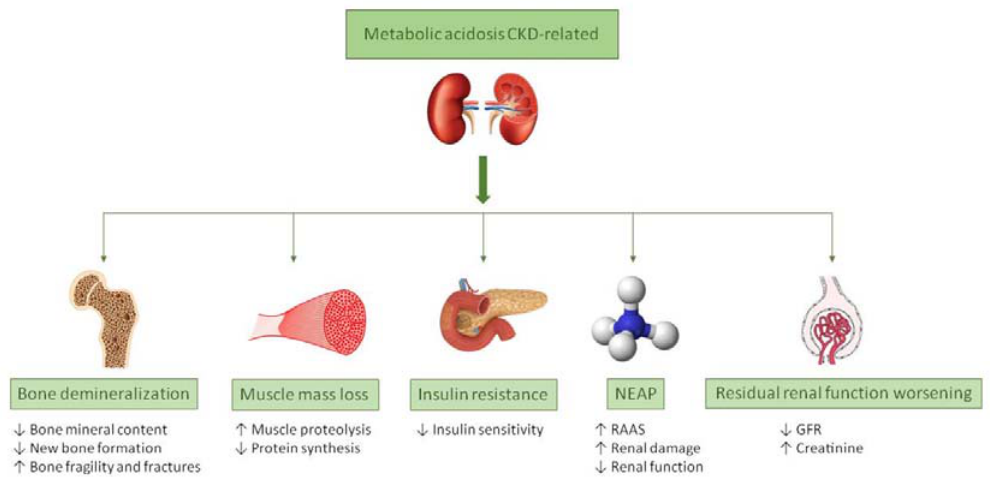
Figure 1. Main consequences of metabolic acidosis in CKD. Abbreviation: CKD, Chronic kidney disease; GFR, glomerular filtration rate; NEAP, net endogenous acid production; RAAS, renin–angiotensin-aldosterone system.